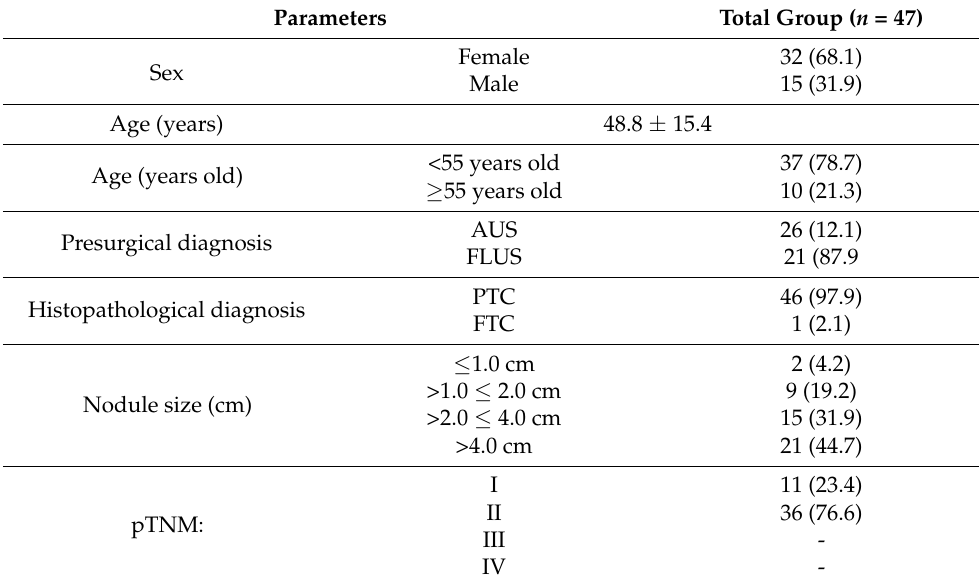
Table 1. Demographic, clinical, and histopathological characteristics of patients with AUS/FLUS diagnosis and final histopathological diagnosis of cancer. Descriptive data are presented as the number of observations (percent) or the mean ± SD.